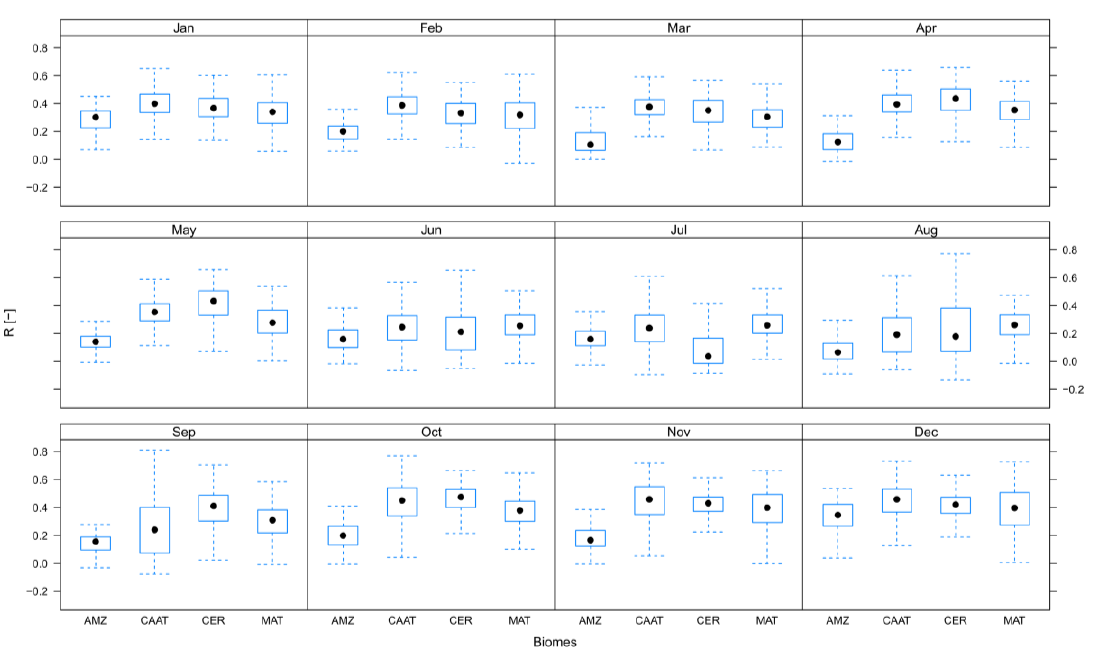
Figure 7. Boxplots for the correlation coefficient obtained by comparing the daily rainfall estimates from the SM2RAIN-CCI against ones from the GBGR dataset grouped per biome and month during the period 1998 – 2015. The components of a boxplot are described in Figure 5.